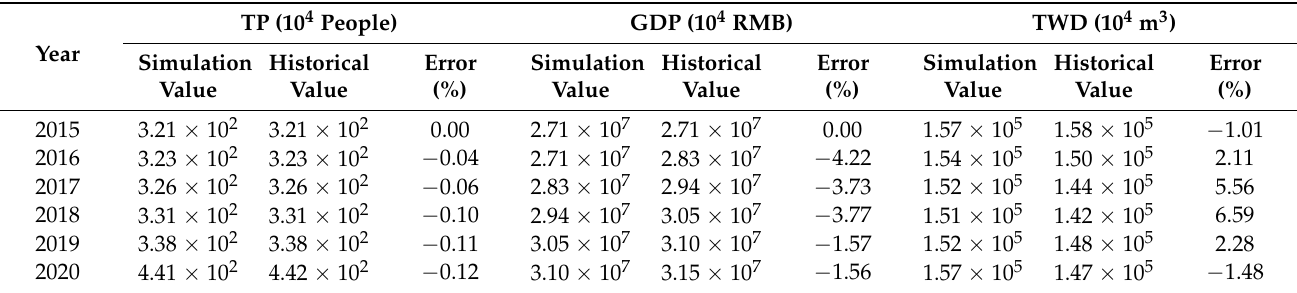
Table 2. The error statistics of model simulation